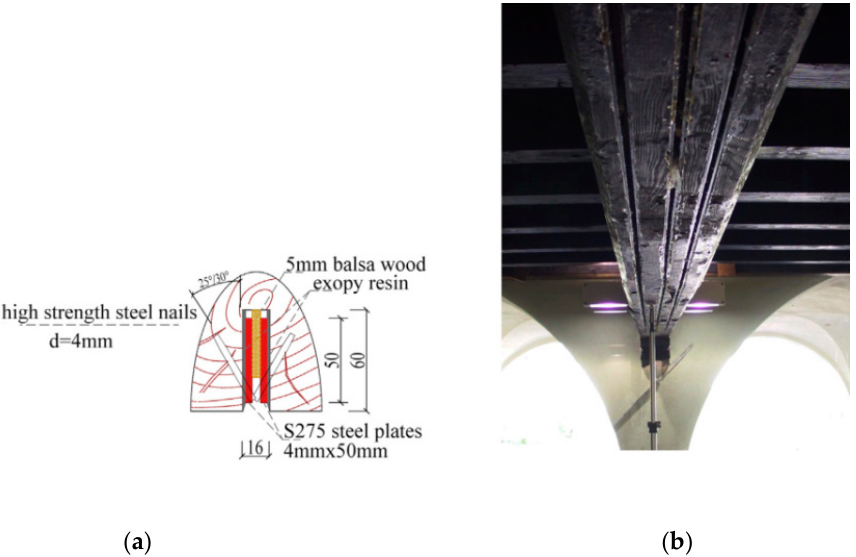
Figure 26. Bonded-in steel strip reinforcement: ( a ) detail of the groove; ( b ) layout of the reinforced beam. Reproduced from [71], with permission from Elsevier, 2016.